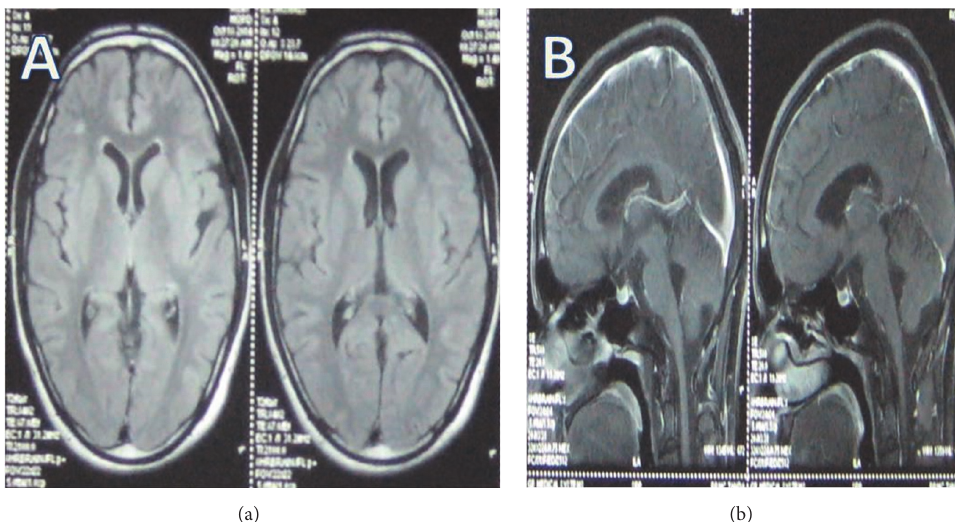
Figure 2: Follow-up MRI 6 months later showing (a) axial FLAIR images showing partially resolved white matter periventricular and subcortical hyperintensities. (b) After contrast, no brainstem meningeal enhancement is